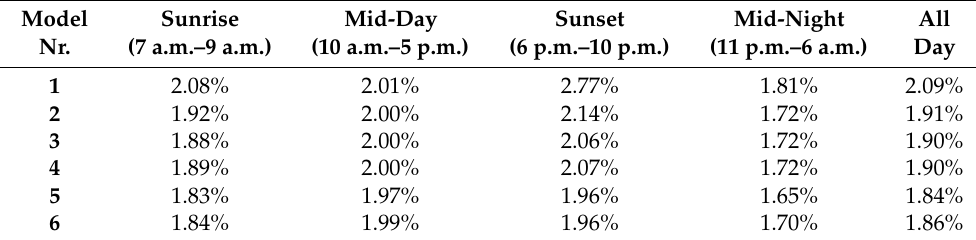
Table 5. Modeling error for each time of day for 2018.